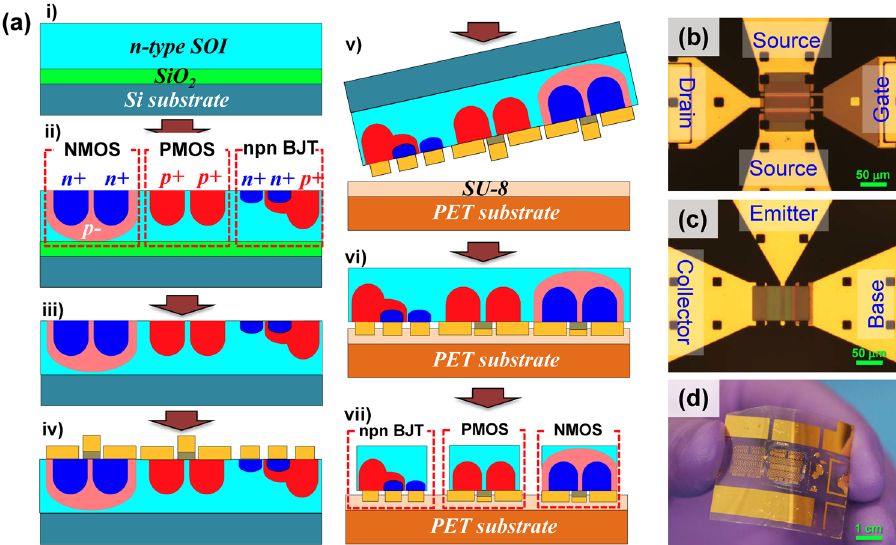
Fig. 1 BiCMOS TFT fabrication process and images a Process fl ow for TFT fabrication. (i) Preparation of n − SOI wafer. (ii) Ion implantations to form p-well, p + and n + regions in the device layer (see Fig. 2 for the detailed sequence of ion implantations). (iii) Released doped Si NM sitting on handling substrate. (iv) Metallization for source/drain/gate and emitter/base/collector electrodes and dielectric deposition for SiO gate oxide layer. (v) NM fl ip-transferred to a PET substrate. (vi – vii) Dry etching of a transferred Si NM to isolate TFTs and to expose electrodes. A microscopic image of Si NM b NMOS TFT, and c NPN BJT. d An optical image of an array of bent BiCMOS